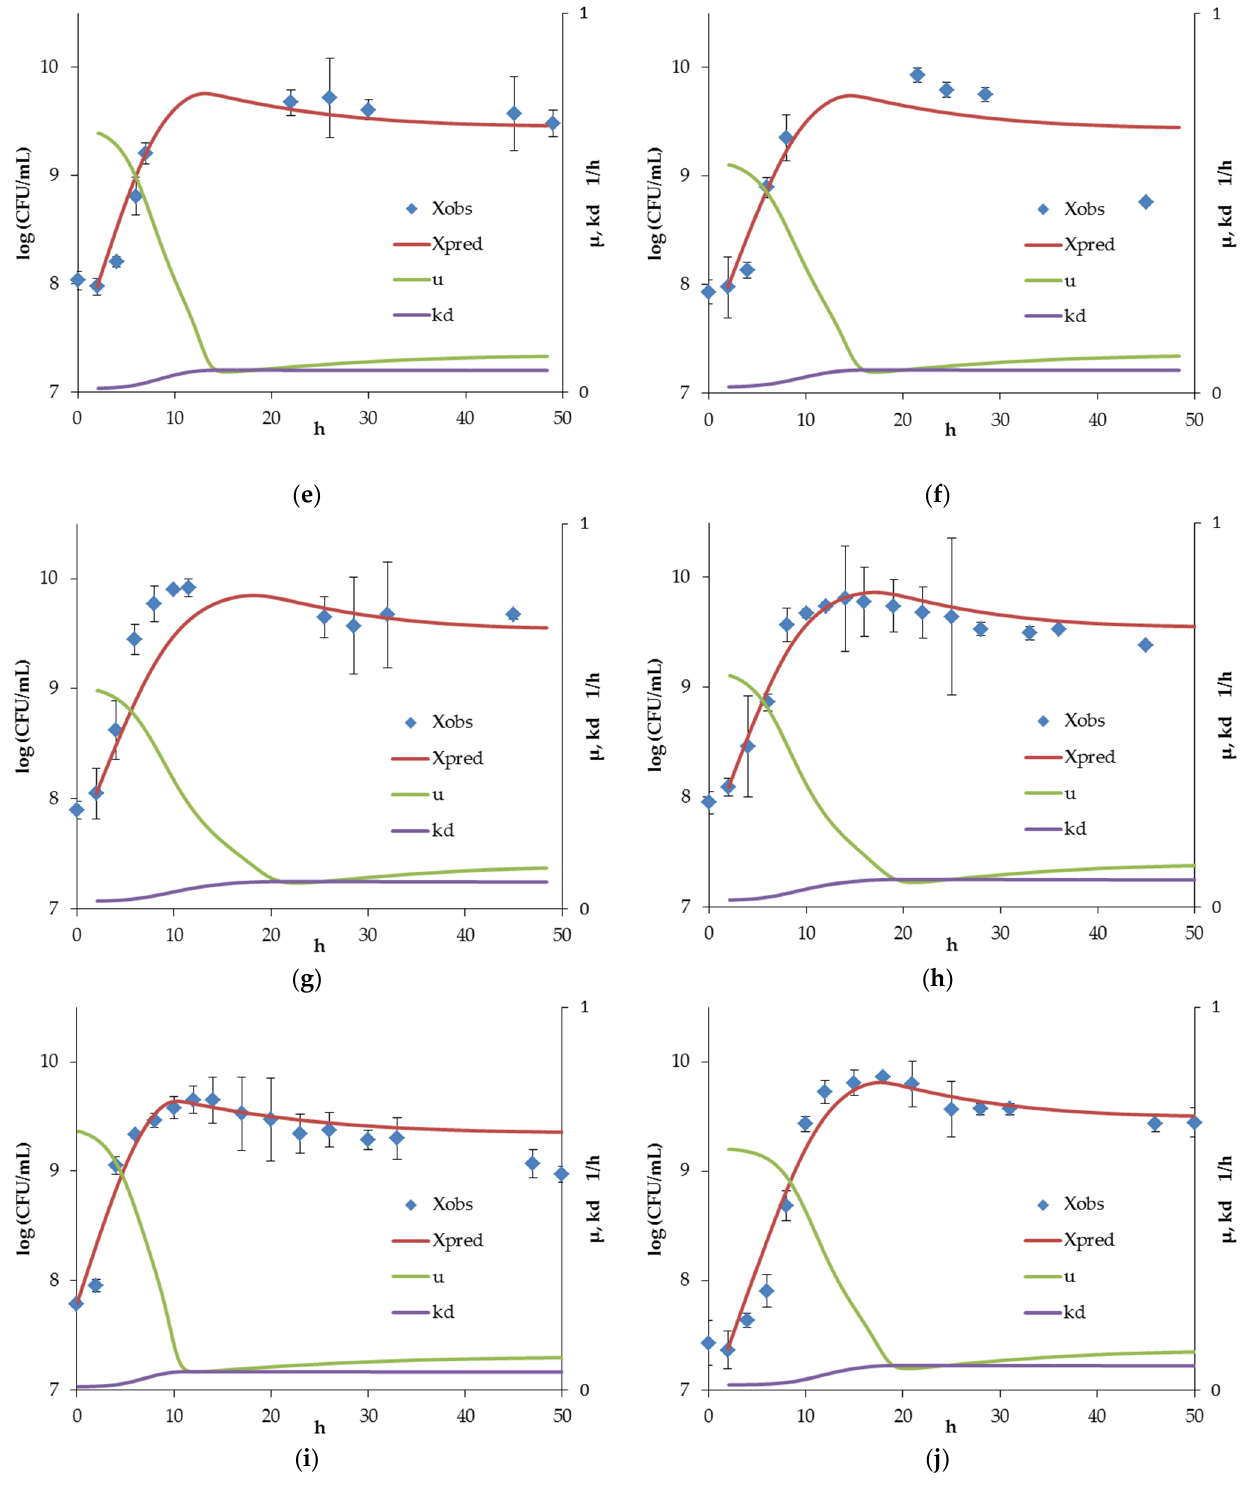
Figure 2. Experimentally observed ( X obs ) and model-predicted ( X pred ) count of Bifidobacterium , along with calculated specific growth rates ( μ ) and death rate constants ( k d ) in monoculture under conditions simulating the distal intestine, at D = 0.04 h − 1 and OF concentrations of 2 ( a , b ), 5 ( c , d ), 10 ( e , f ), 15 ( g , h ), 7 ( i ), and 12 mg/mL ( j ).